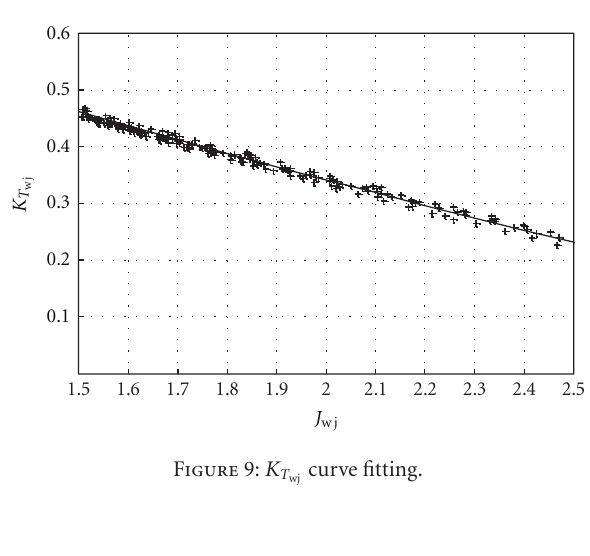
curve fitting. wj